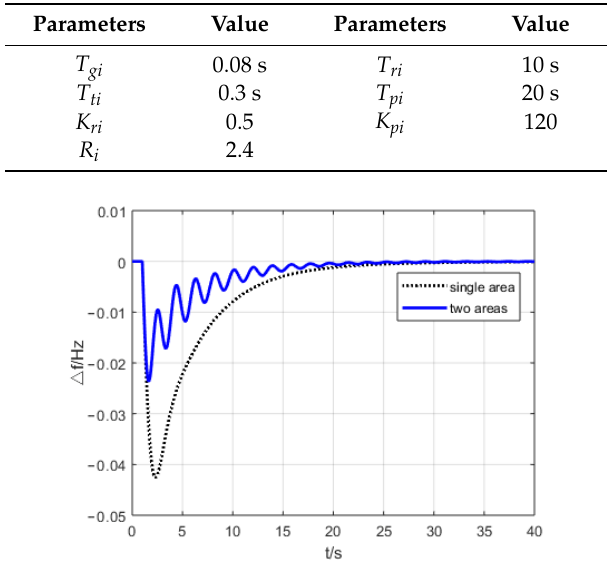
Figure 5. Single and two-area frequency variation chart of reheat steam turbine.